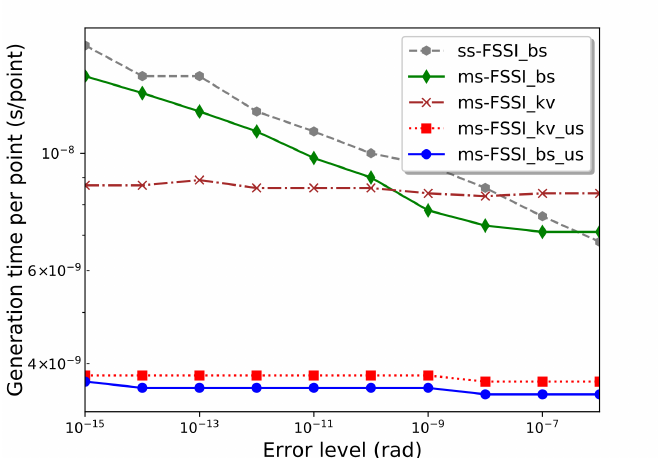
Figure 4. Generation time per point ( s / N ) as a function of the error level for different routines, as applied to the inversion of f ( x ) = x e sin x with e = 0.9. The plotted values correspond to the CPU − execution time for generating N = 10 7 points, divided by N . These results have been obtained with the computer hardware specified in the